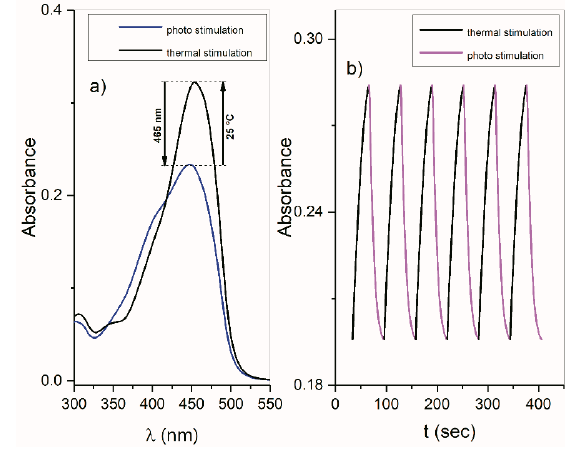
Figure 9. ON and OFF states of hydrazone 1 (1 × 10 − 5 mol.dm-3) in the presence of TBAF (5 × 10 − 4 mol.dm − 3 ) at 25 °C: ( a ) UV-Vis spectra, ( b ) kinetic record—thermal and photochemical stimulation.